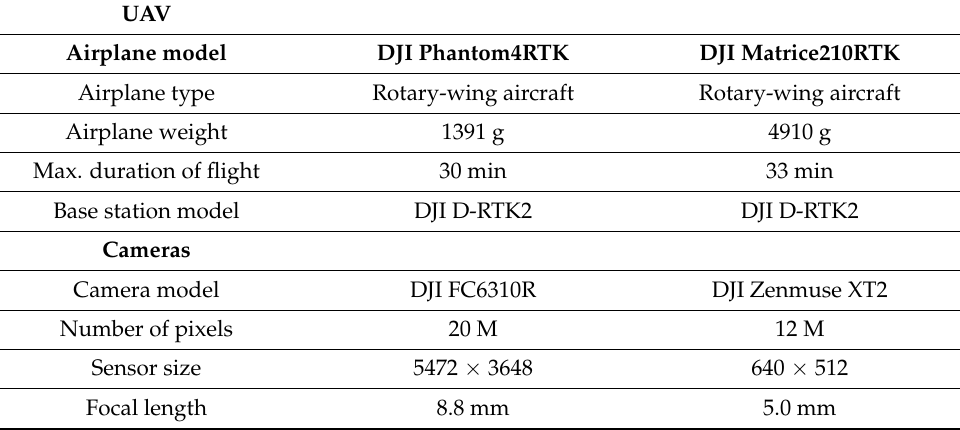
Table 1. General information related to the unmanned aerial vehicle (UAV) and cameras.